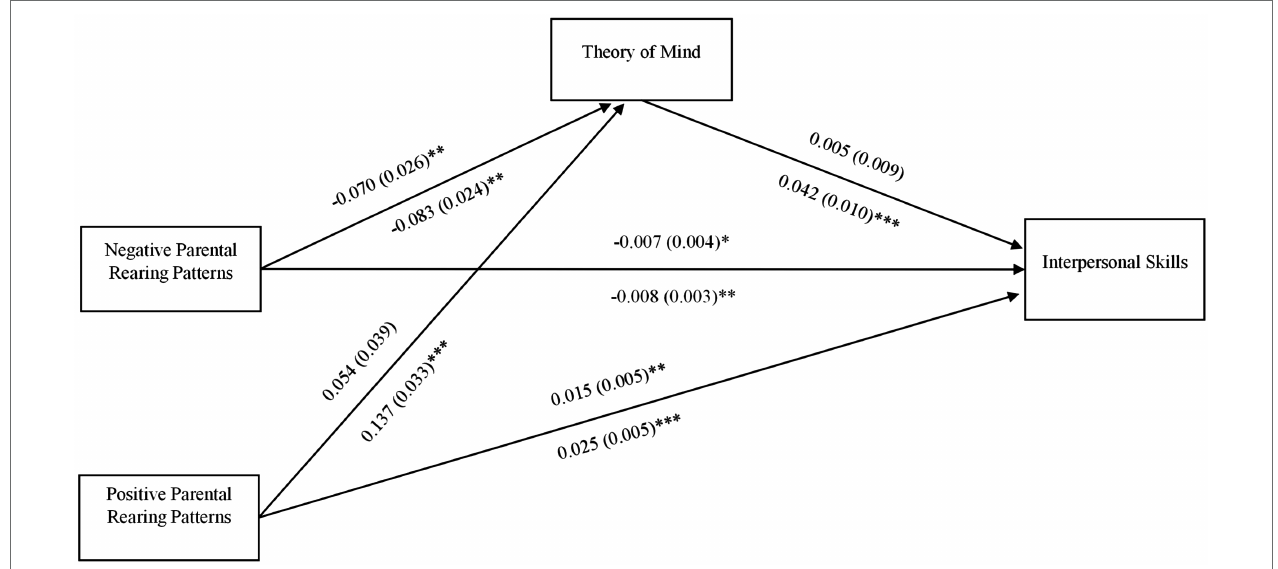
FIGURE 2 | Indirect effects of parental rearing patterns on interpersonal skills via ToM, by gender. Path coefficients (b and standard error, SE) are unstandardized. Path coefficients above the arrows were for male participants, and those below the arrows were for female participants. Model controlled for potential effect of age on ToM and interpersonal skills. *** p < 0.001; ** p < 0.01; * p <